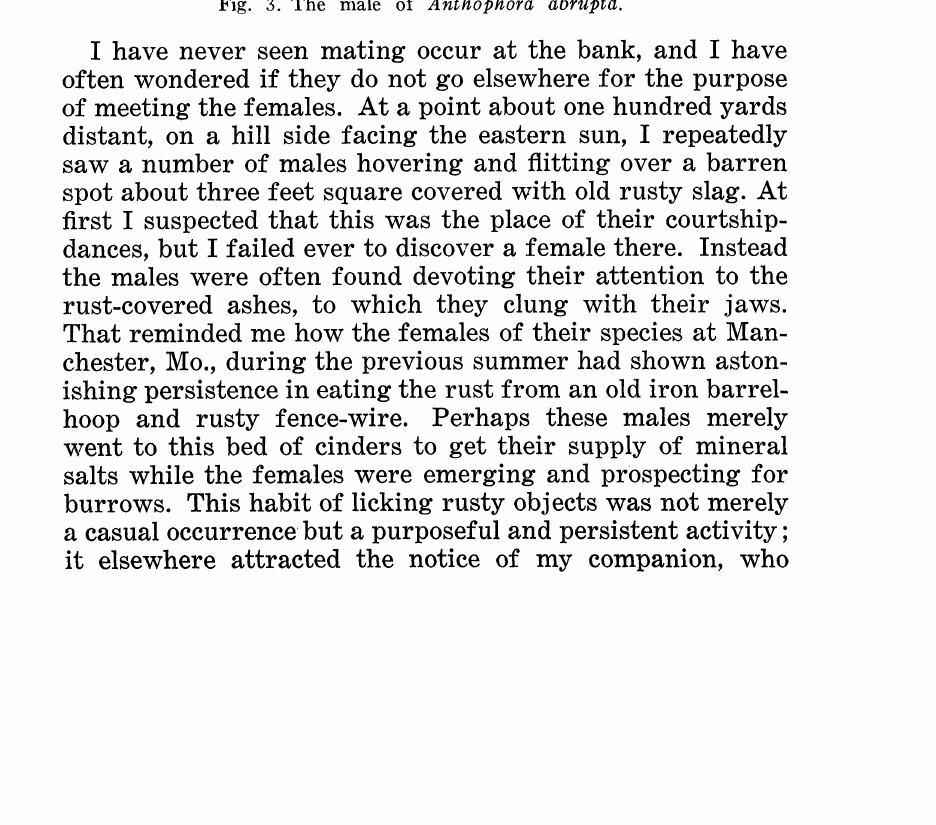
Fig. 3. The male of Anthophora